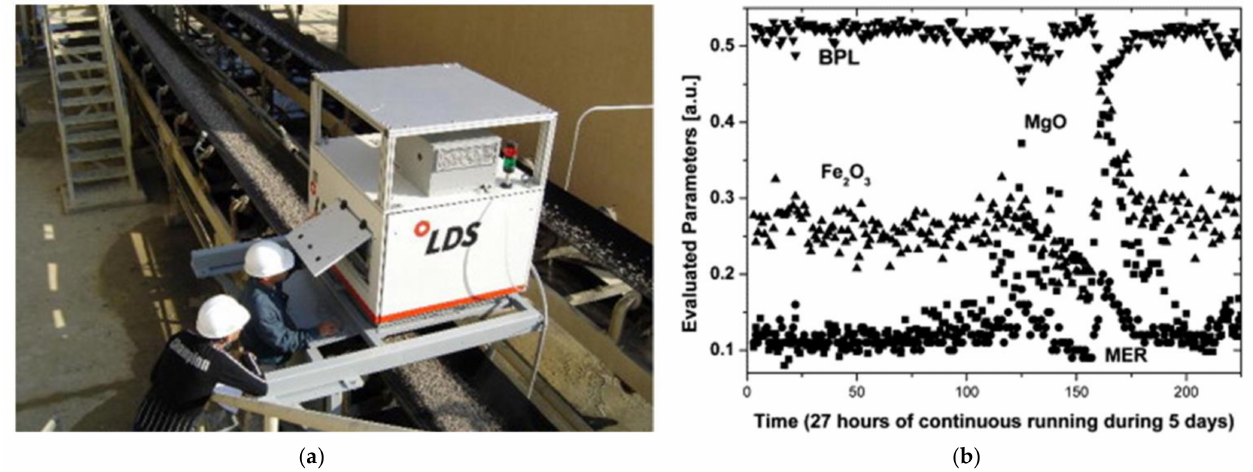
Figure 11. LIBS in-line measurement of phosphate minerals. ( a ) Photograph of LIBS sensor installed above a conveyor belt in the Four Corners Mine, Florida (USA). ( b ) MgO, Fe 2 O 3 , BPL, and MER measured by LIBS over several days. Adapted from